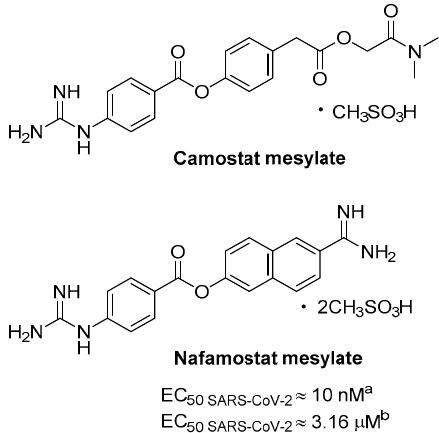
Figure 11. Chemical structures of phenyl-4-guanidinobenzoate derivatives known drugs as serine protease and antiviral activity of nafamostat agaisnt SARS-CoV-2 in Calu-3 cells measured by CPE; a pre-treatment; b added after virus inoculation.